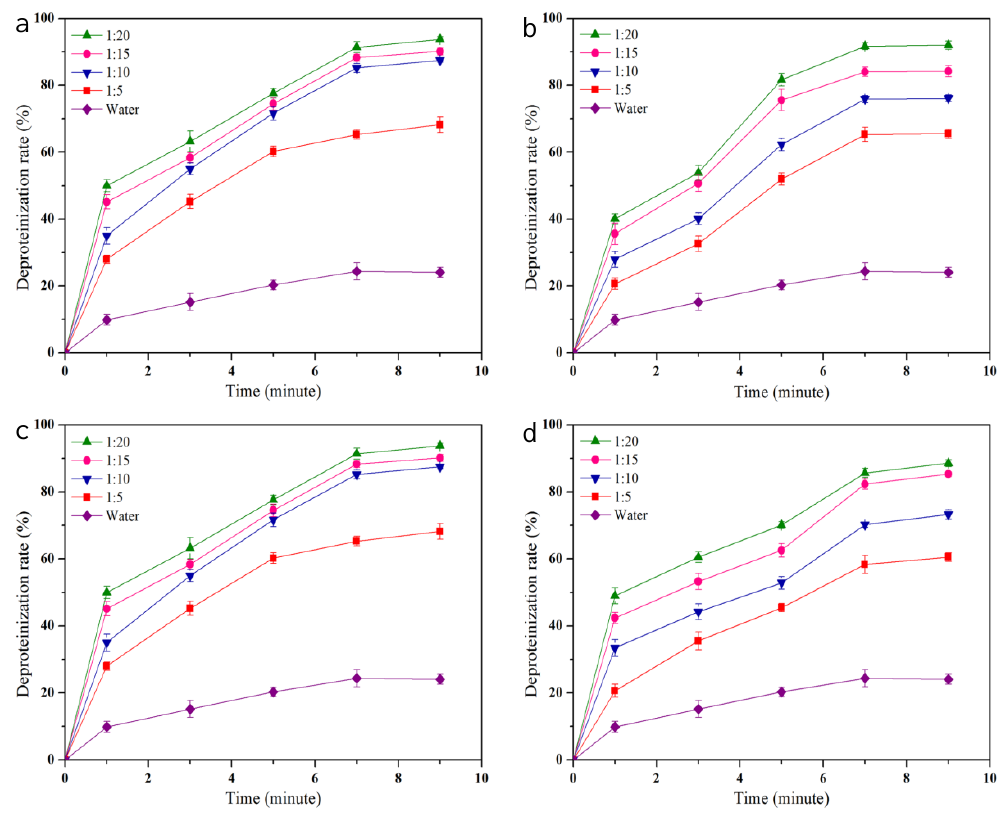
Figure 2. Deproteinization rates of ( a ) betaine HCl-urea, ( b ) ChCl-urea, ( c ) ChCl-ethylene glycol, and ( d ) ChCl-glycerol at shrimp shell/NADES ratios of 1:5, 1:10, 1:15, and 1:20.